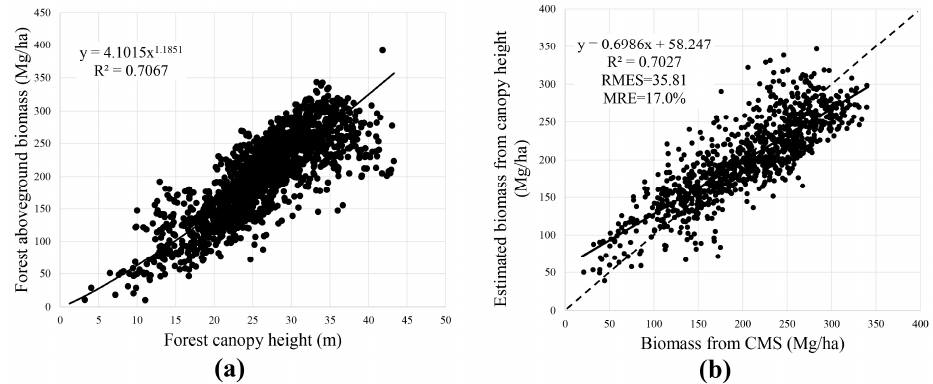
Figure 7. Forest aboveground biomass model and the evaluation results. ( a ) Power model to estimate forest aboveground biomass; and, ( b ) Evaluation result of the biomass estimation model.